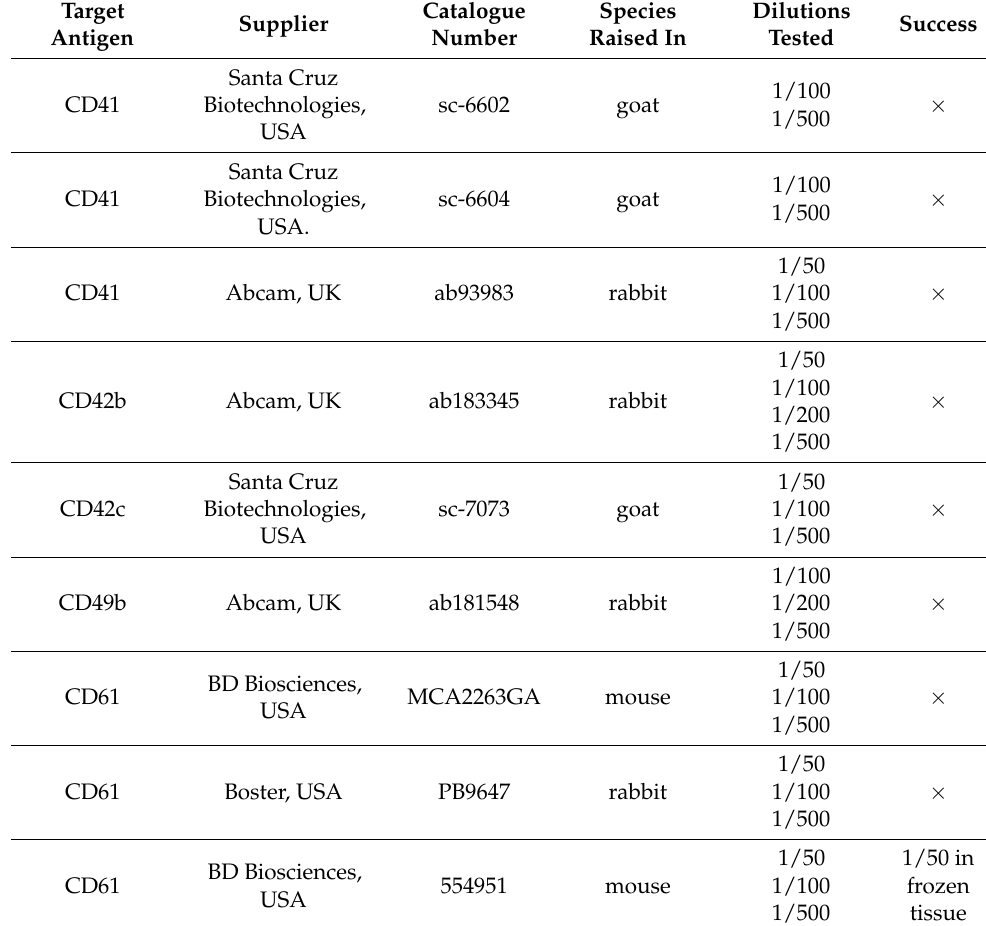
Table 2. Platelet-specific antibodies tested in rat